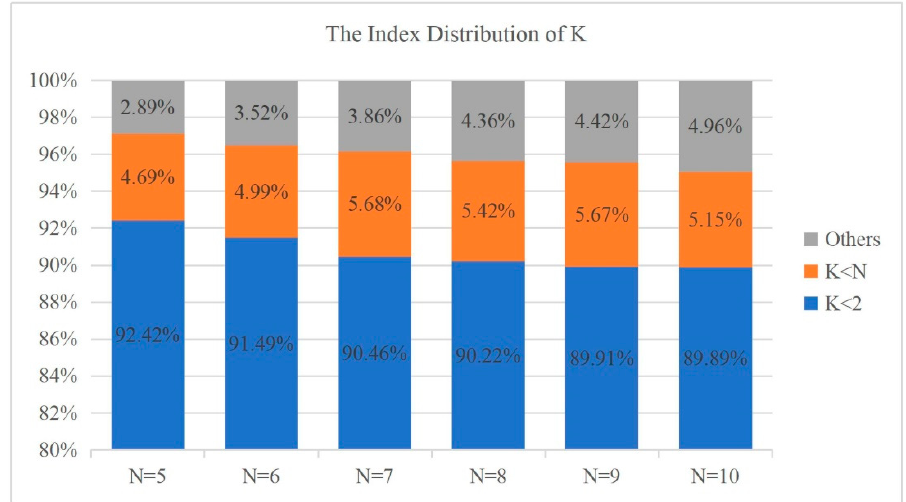
Figure 5. The index distribution of the K value of the maximum offloading action in KNN within 10,000 time blocks when the number of UAVs varies from 5 to 10.